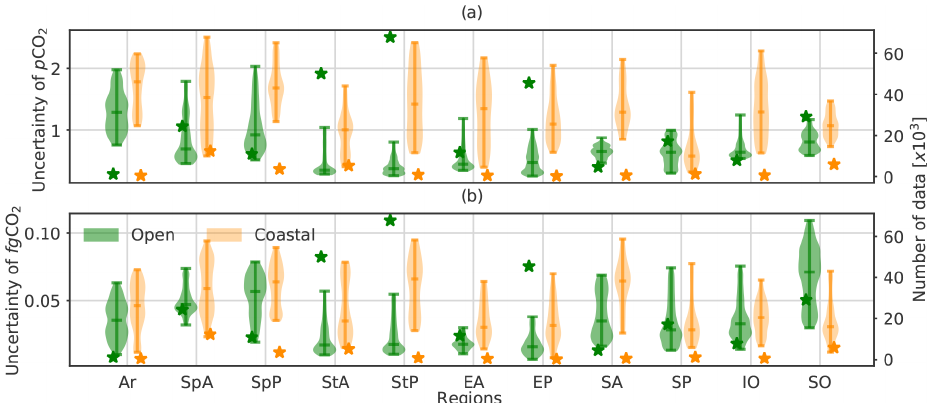
Figure 7. Distribution (violin) of all uncertainty estimates (Fig. 5c and d) and the total number (star) of gridded SOCAT data (Fig. S1a) split for 11 RECCAP1 regions. A violin plot shows the range, median, and density of uncertainty estimates for p CO 2 (µatm) and fg CO 2 (molCm − 2 yr − 1 ).